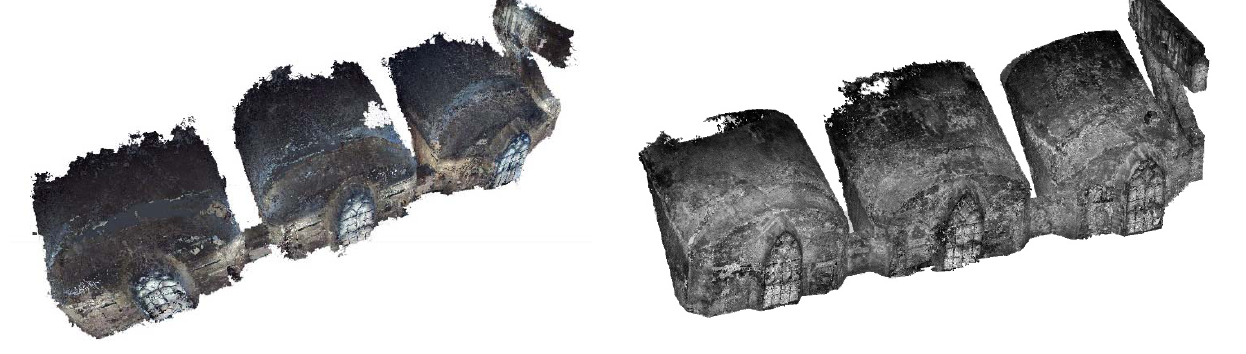
Figure 9. The Canon 5D Mark II with 8 mmm lens point cloud, 79.373.512 points, 5